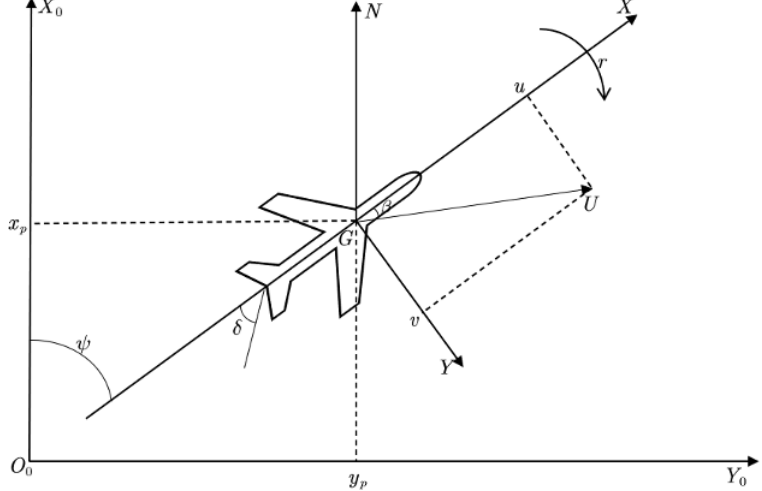
Fig. 1. Diagram of UAV track tracking.